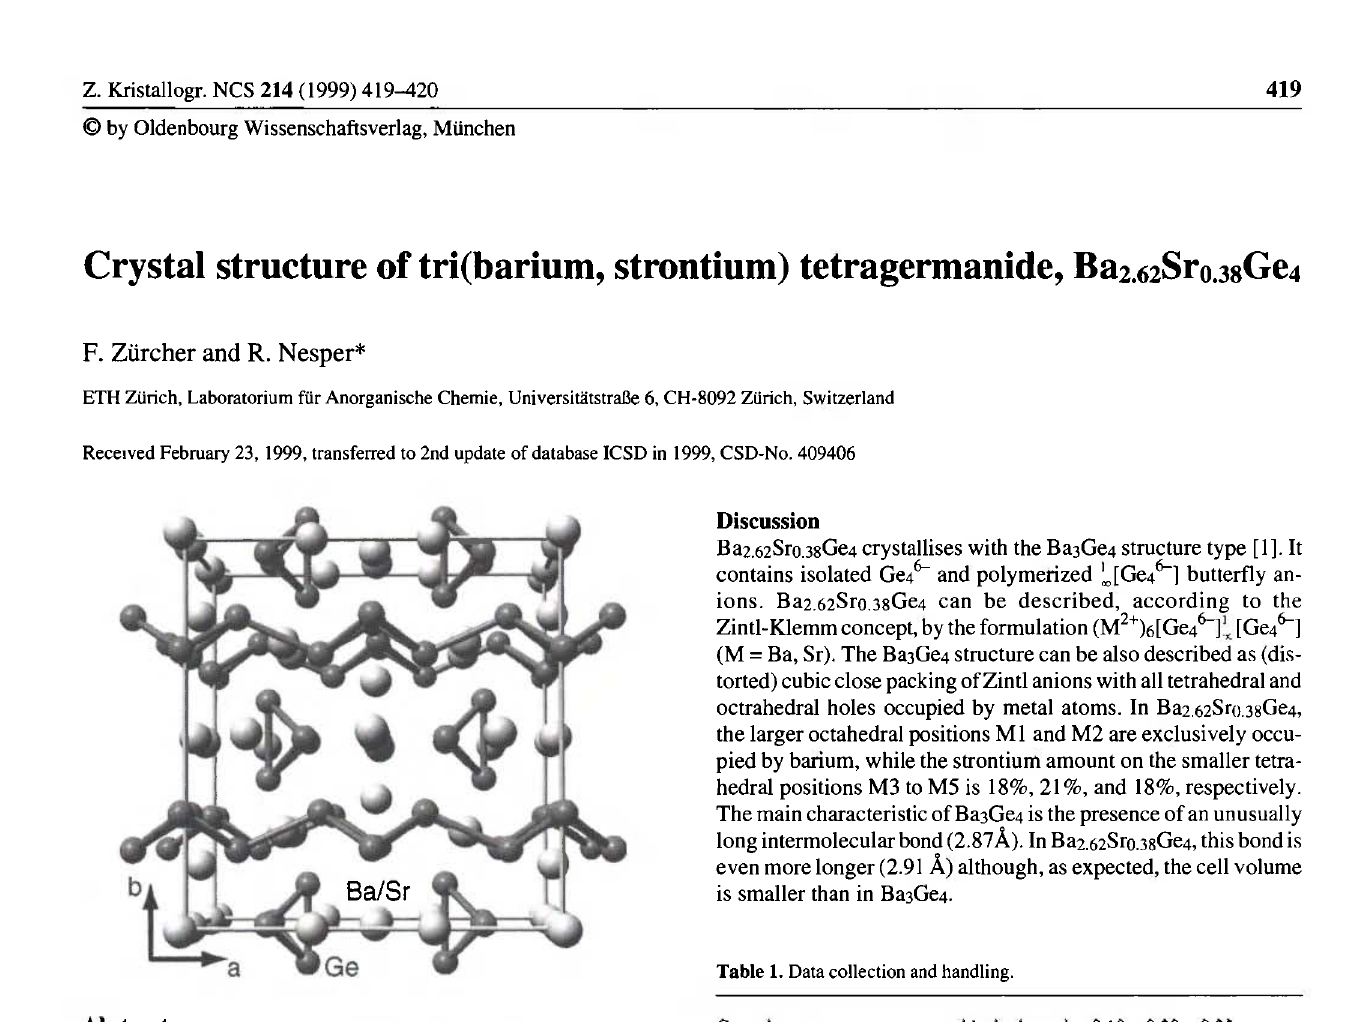
Table 2. Atomic coordinates and displacement parameters (in Ä 2